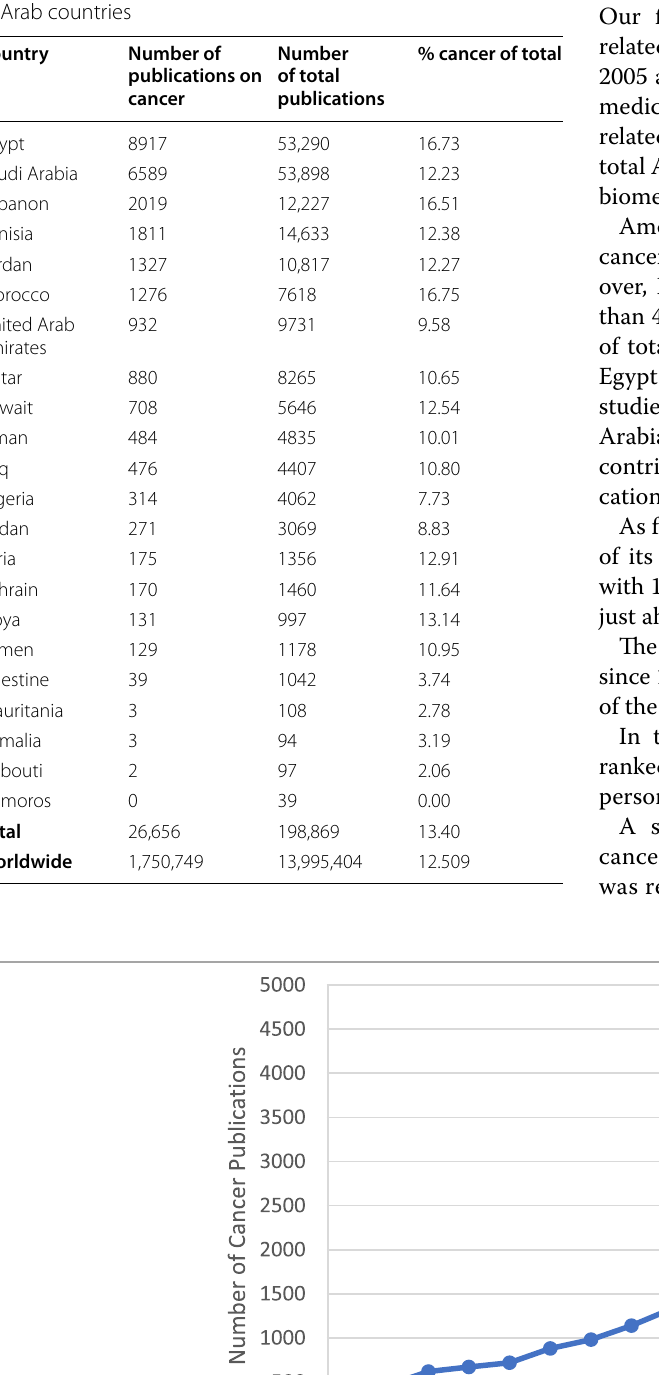
Table 1 Number and percentage of cancer-related publications